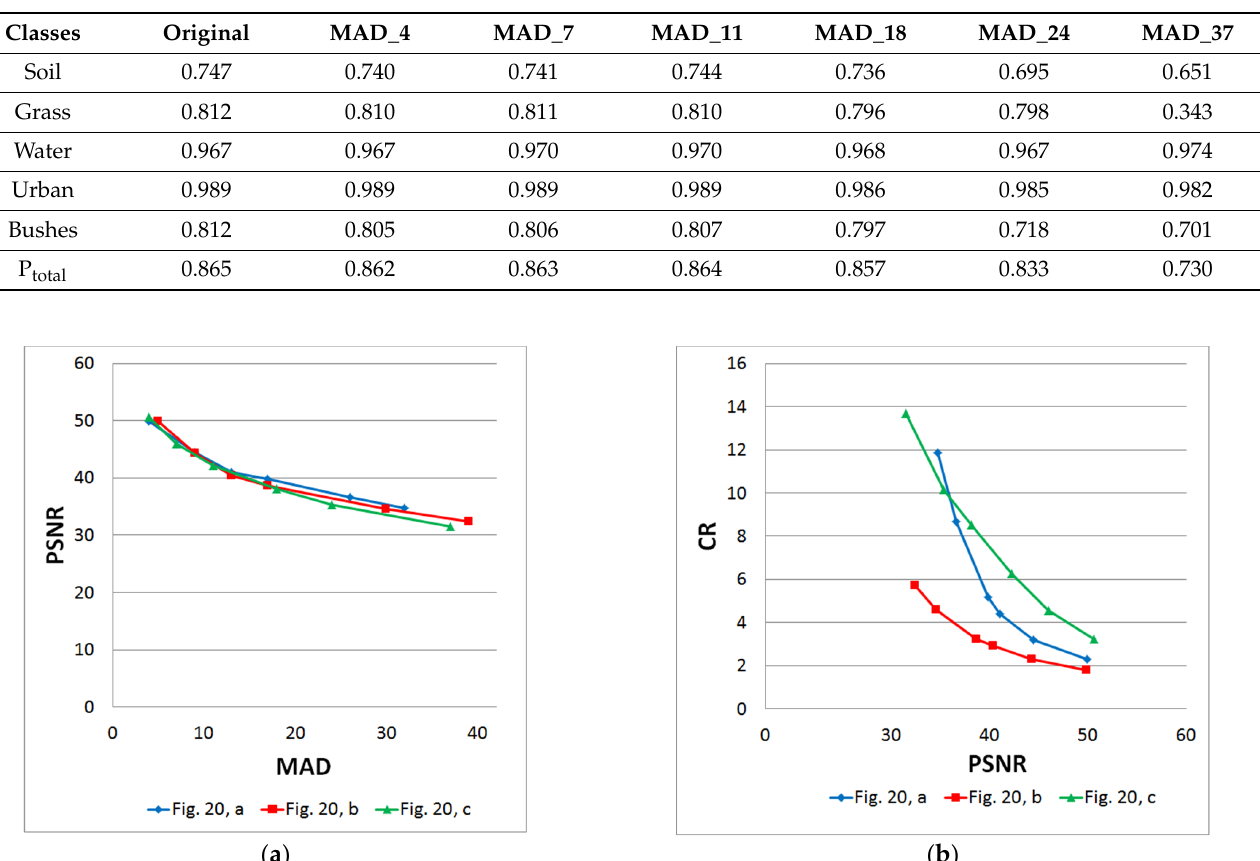
Table 20. Total probabilities of correct classification for depth 2 and different MAD for the image in Figure 20c using the ML classifier.